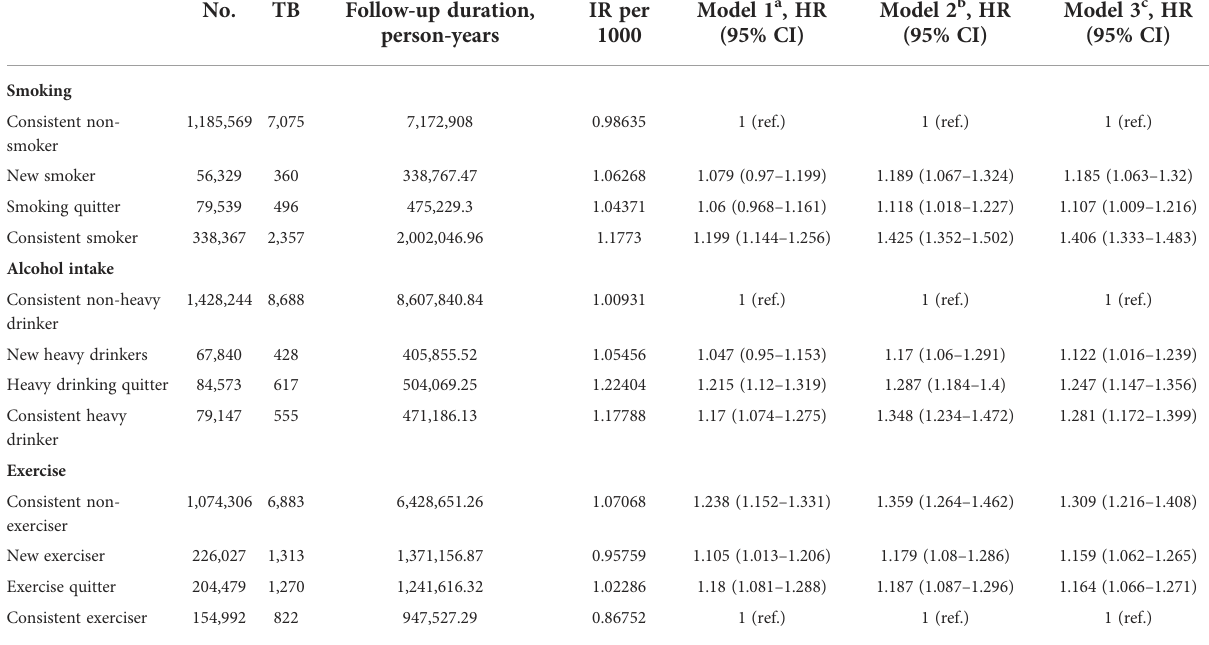
TABLE 2 The associations between lifestyle changes and development of TB.